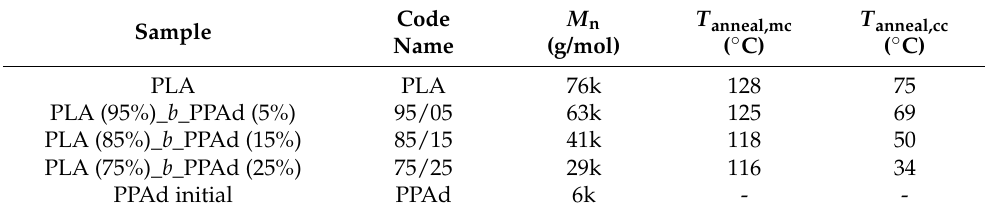
crystallization, T anneal,mc and T anneal,cc , for melt- and cold-crystallization, respectively.